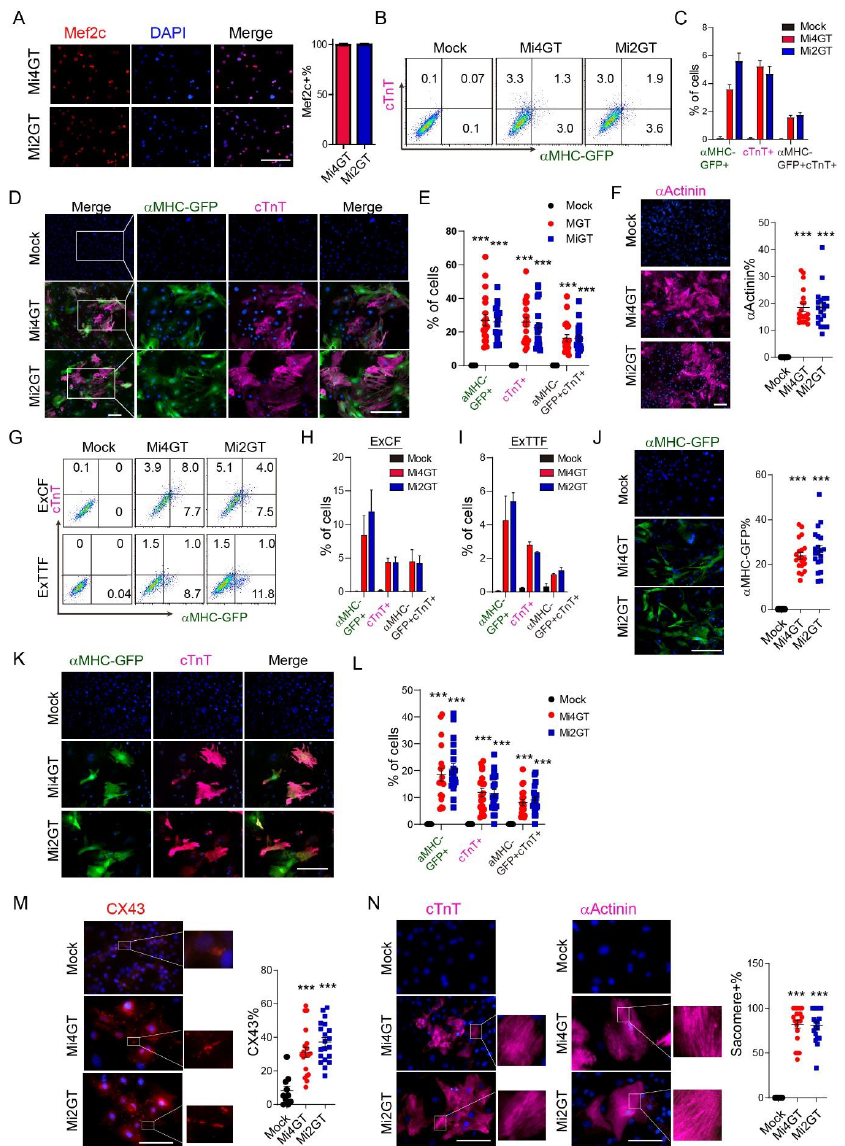
Figure 3. Mef2C isoforms yielded similar reprogramming efficiency in cardiac fibroblasts (CFs) and tail-tip fibroblasts (TTFs). ( A ) Immunofluorescence analysis of Mef2C expression in Mi4GT and Mi2GT retrovirus infected cells. ( B ) Representative flow cytometry plots of cTnT + , α MHC-GFP + , and double positive iCMs generated from fCF. ( C ) Quantification of the flow cytometry data. ( D ) Representative immunocytochemistry (ICC) images of iCMs generated using polycistronic constructs, Mi4GT and Mi2GT. ( E ) Statistical analysis of the immunocytochemistry data. ( F ) Representative ICC images and quantification of α Actinin expression in the generated iCM from fCFs. ( G ) Representative flow cytometry plots of cTnT + , α MHC-GFP + , and double positive iCMs generated from ExCF and ExTTF. Quantification of the flow cytometry data of ExCF ( H ) and ExTTF ( I ). ( J – L ) Representative ICC images and quantification of the α MHC-GFP + and cTnT + cells, in iCMs generated from ExCF and ExTTF, using Mi4GT and Mi2GT. ( M ) Representative ICC images of connexin 43 (CX43) between both iCMs generated by Mi2GT and Mi4GT. ( N ) Representative ICC images of the sarcomere structure in iCMs generated by Mi2GT and Mi4GT. Scale bar, 200 µ m. For each experiment, n = 3; averaged numbers from technical triplicates, or at least 10 random ICC fields were used for statistics. All data are mean ± SEM. *** p < 0.001. Statistical analysis was performed with one-way ANOVA, followed by Tukey’s